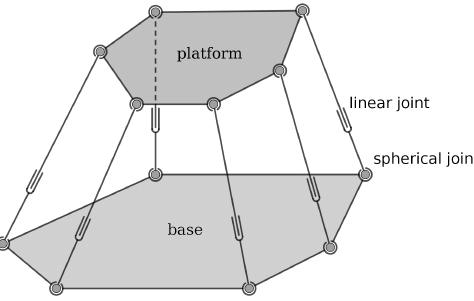
Figure 1. The 6-SPS Stewart